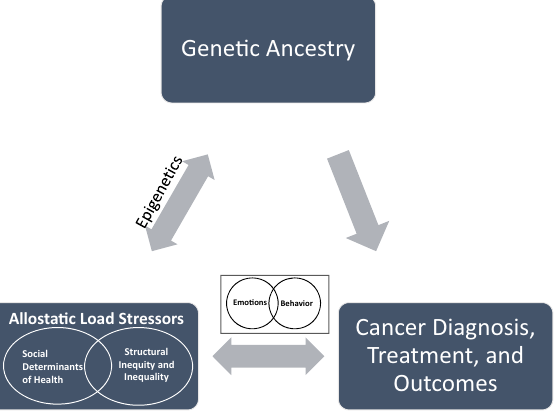
Fig. 1 Allostatic load framework for understanding disparities in Black breast cancer patients. This fi gure describes the relationship between genetic ancestry, allostatic load stressors, and cancer diagnosis, treatment, and